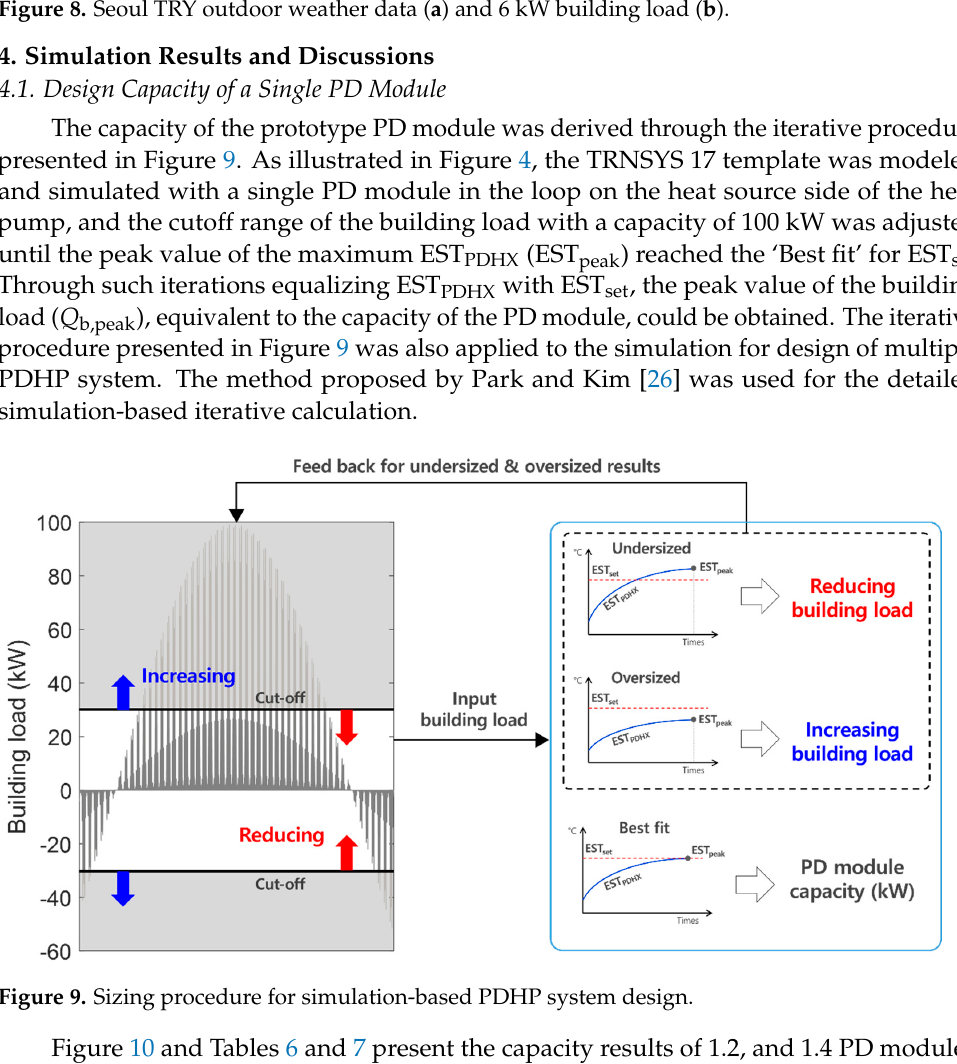
Figure 8. Seoul TRY outdoor weather data ( a ) and 6 kW building load ( b ).